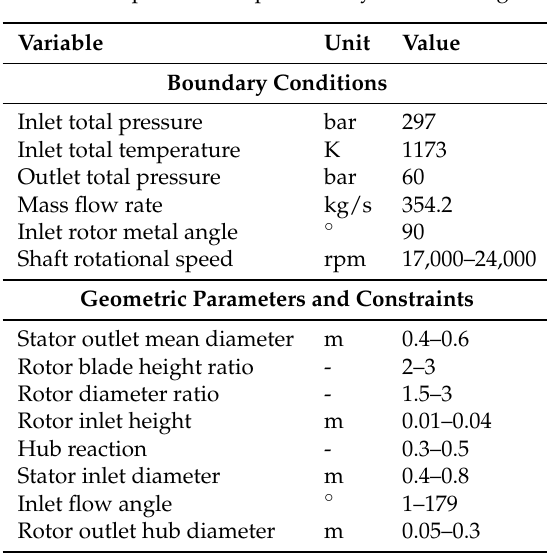
Table 5. Input data for preliminary turbine